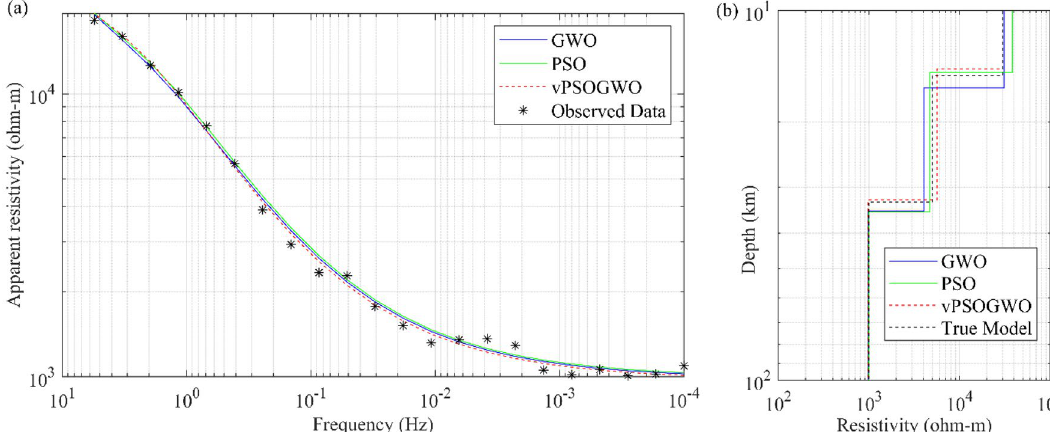
Figure 7. Three-layer noisy MT synthetic data: ( a ) observed apparent resistivity curve (*) and the best-fitted apparent resistivity curve using vPSOGWO, GWO, and PSO; ( b ) 1D mean model (bpdf > 68.27% CI) inverted by vPSOGWO (red), GWO (blue) and PSO (green) with a true model (black).